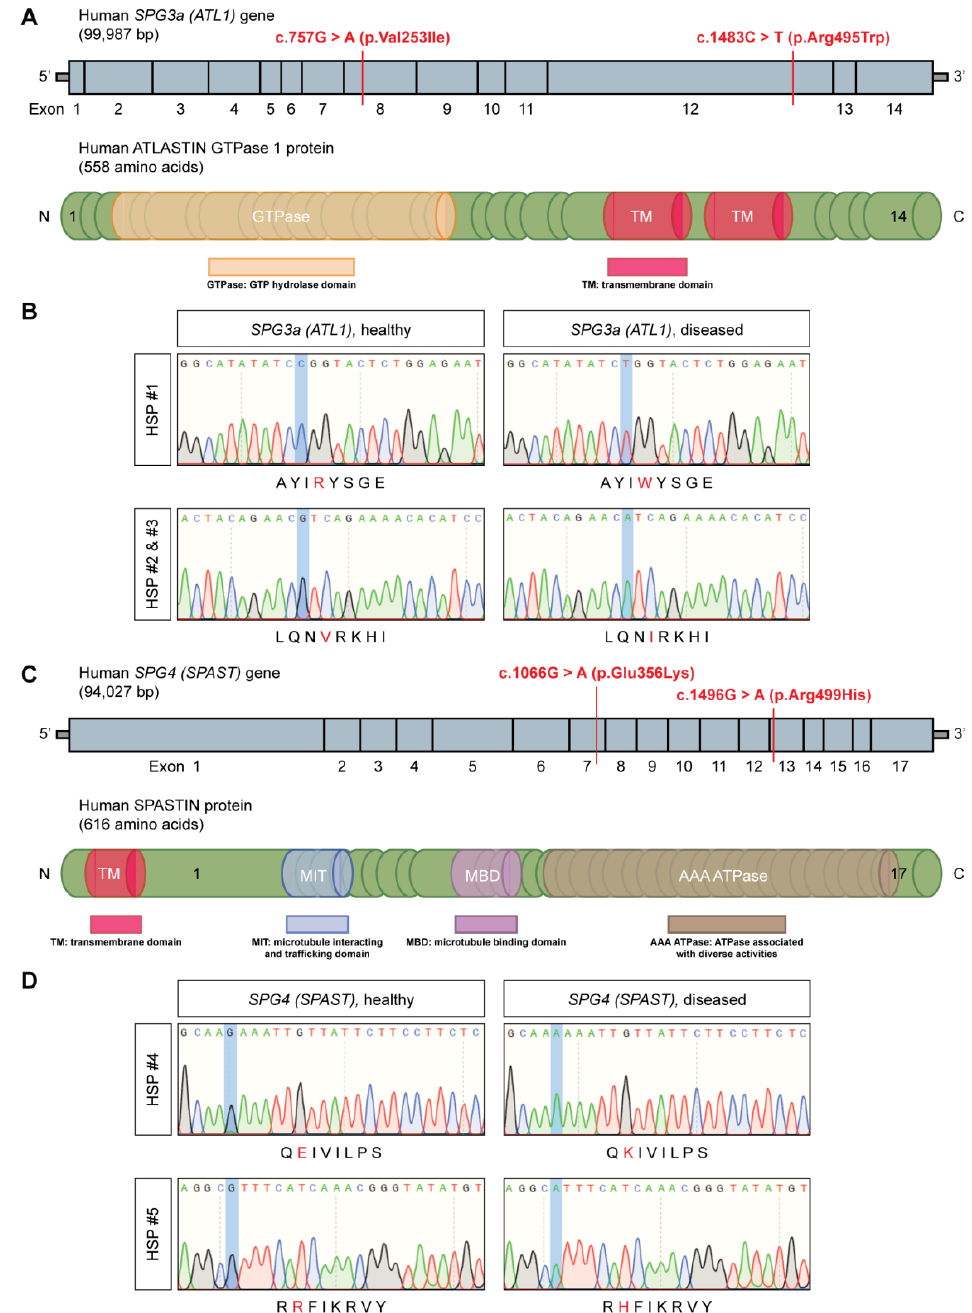
Figure 1. Genetic mutations of the HSP study subjects. ( A ) Illustration of the human SPG3a ( ATL1 ) gene (top) and the encoded ATLASTIN GTPase 1 protein (bottom). The three SPG3a -HSP patients were characterized by a missense mutation that is, respectively, located in exon 8 (c.757G > A; p.Val253Ile) or exon 12 (c.1483C > T; p.Arg495Trp) of the SPG3a gene. ( B ) DNA sequencing of the mutated region of interest of SPG3a (mutation highlighted in blue) and corresponding amino acid sequences (indicated in red). ( C ) The human SPG4 ( SPAST ) gene (top) and its encoding SPASTIN protein (bottom). The two SPG4 -HSP patients presented a missense mutation in, respectively, exon 7 (c.1066G > A; p.Glu356Lys) or exon 13 (c.1496G > A; p.Arg499His) of the SPG4 gene. ( D ) DNA sequencing of the mutated region of interest of SPG4 (mutation highlighted in blue) and corresponding amino acid sequences (indicated in red).